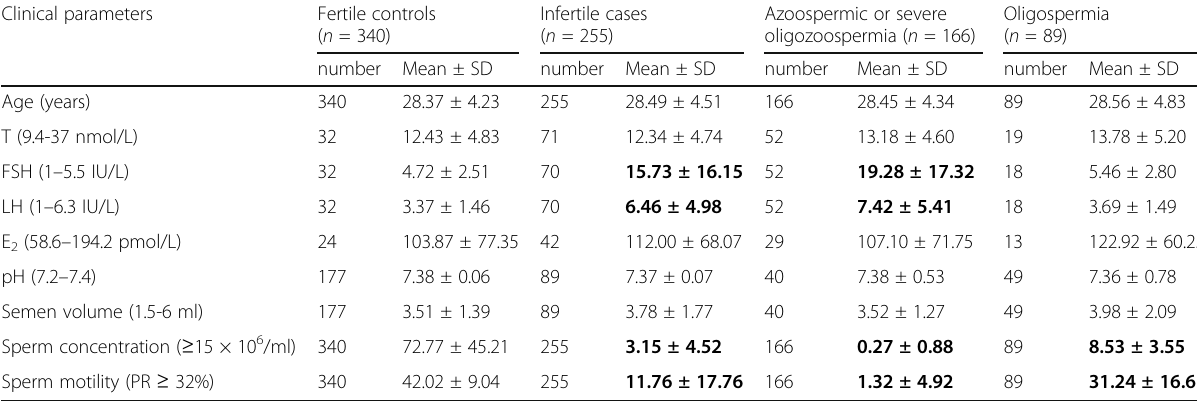
Table 1 General characteristics of the study group Clinical